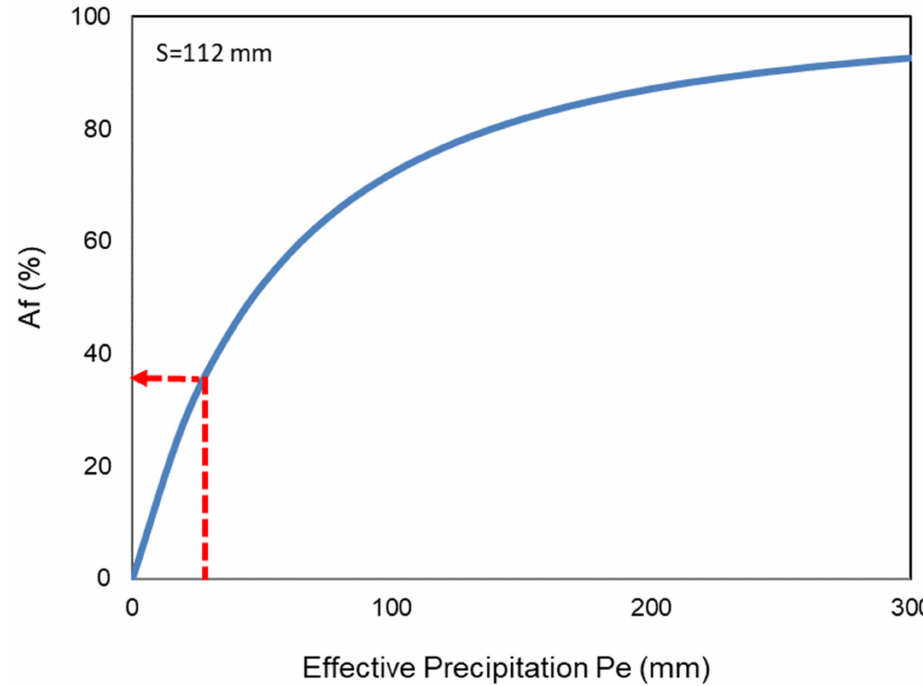
Figure 4. Distributed CN-VSA method—step 2: a line graph between P e (effective precipitation) and S (potential maximum retention) to determine A f (fraction of runoff-generating area).